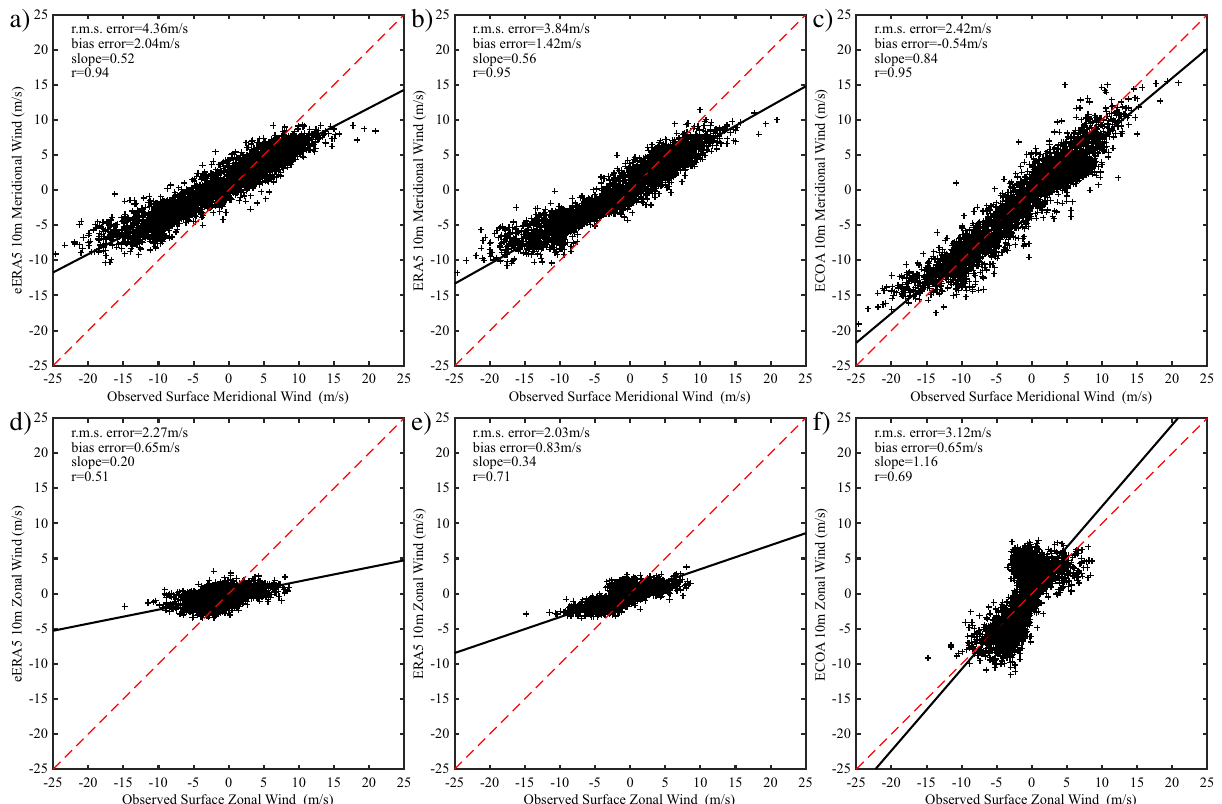
Figure 6. Scatterplots of the observed 6-hourly components of the surface wind and the components of the 10 m model wind at Hans Island. Results are shown for the meridional component for the: (a) eERA5, (b) ERA5 and (c) ECOA. Results are also shown for the zonal component for the: (d) eERA5, (e) ERA5 and (f) ECOA. Data from January 1 2016-September 30 2020 excluding May–July 2016 was